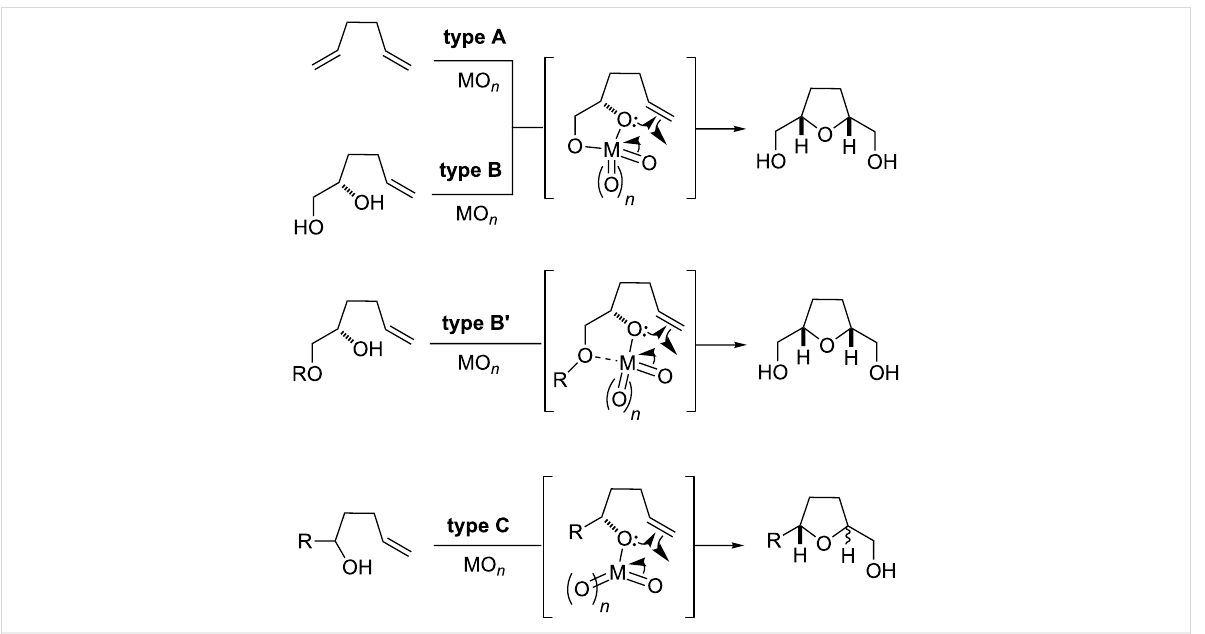
Scheme 3: Mechanisms and classification for the metal-mediated oxidative cyclizations to form 2,5-disubstituted THFs.